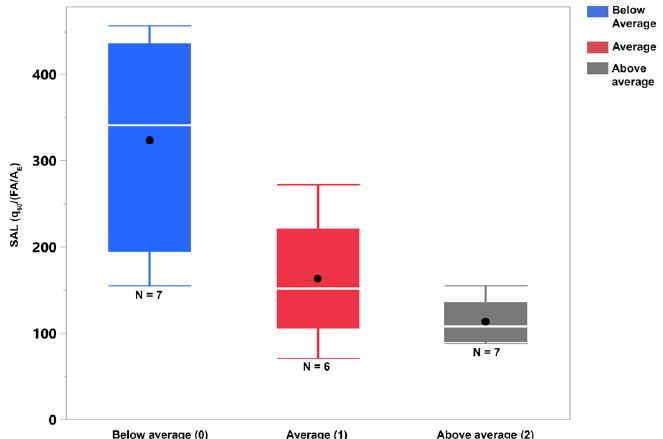
Figure 14. Box and whisker plots showing the distribution of SAL (q 50 /(FA/A E )) across the three observed fenestration quality categories (dots show the mean value).